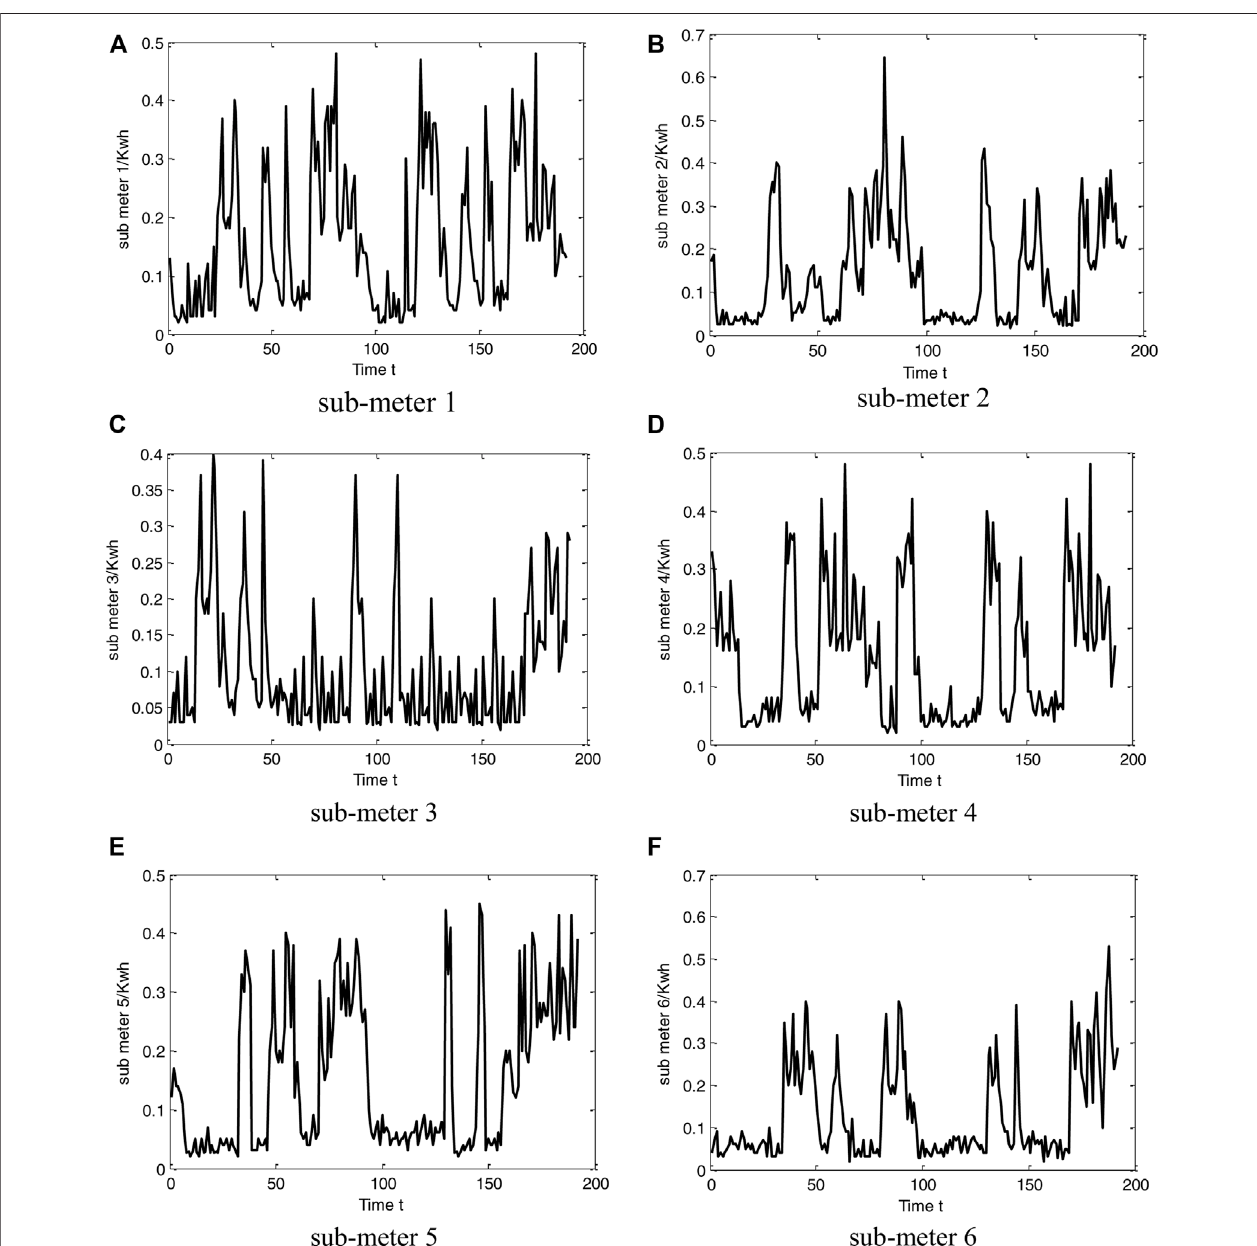
FIGURE 4 | The data from six smart electricity meters: (A) sub-meter 1, (B) sub-meter 2, (C) sub-meter 3, (D) sub-meter 4, (E) sub-meter 5, and (F) sub-meter 6.